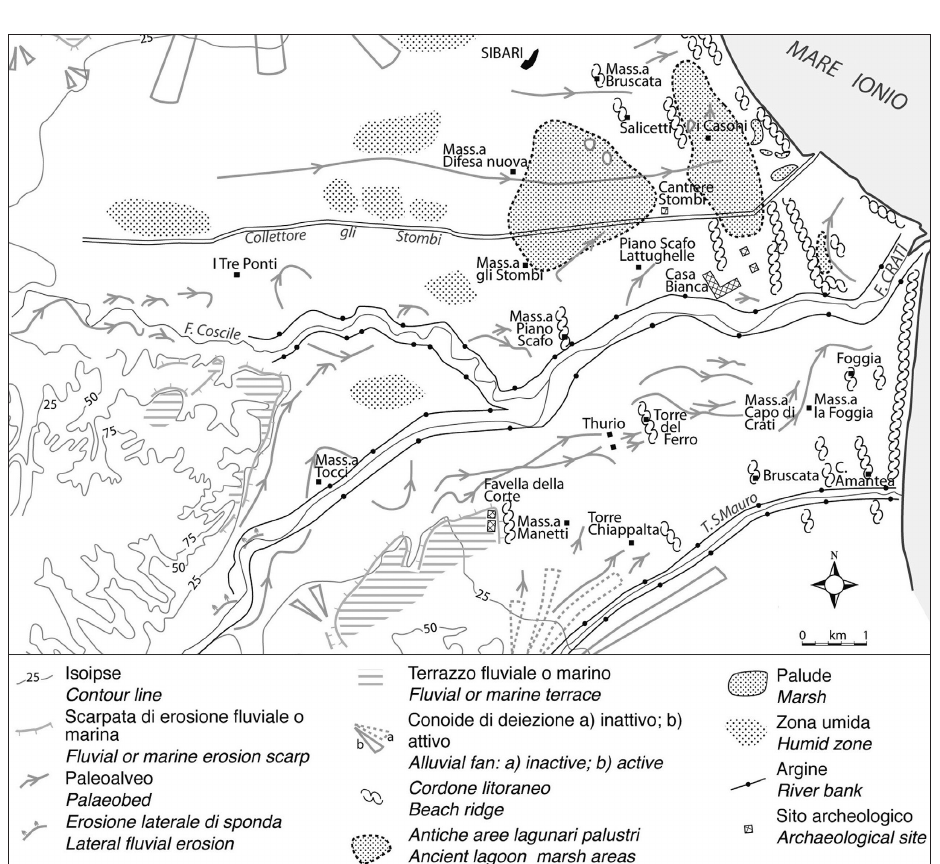
Figure 3: Geomorphologic map of the Crati river delta Plain (Bellotti et al. 2009: fig.